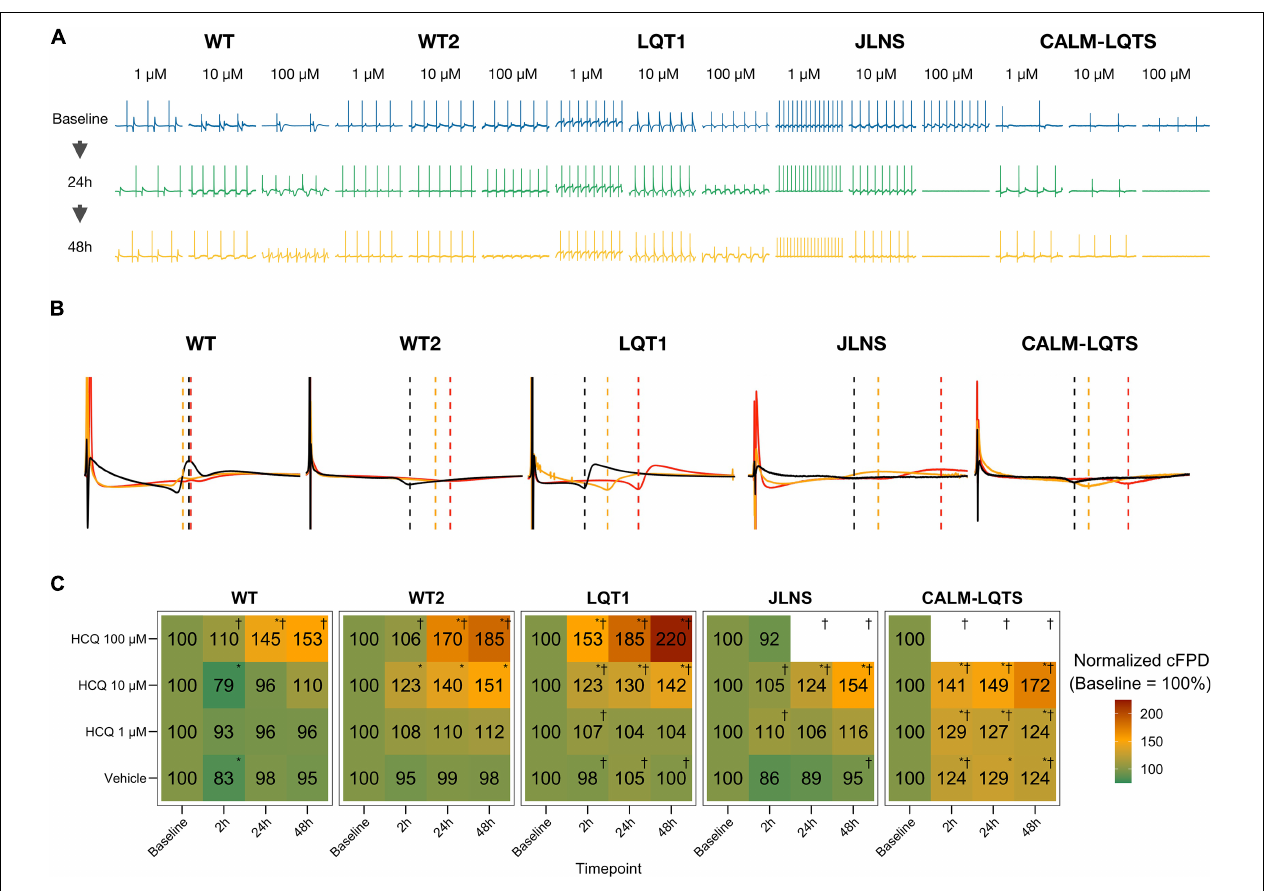
FIGURE 4 | (A) Representative examples of HCQ effect on MEA recordings. (B) Representative mean FP profiles of MEAs treated with 10 µ M HCQ at Baseline (black), after 24 h (yellow) and 48 h (red) exposure. (C) Mean FPD change, expressed as% and normalized to the respective Baseline value. Color code indicates the relative cFPD change compared to Baseline. * Indicates p < 0.05 vs. Baseline. † Indicates that the treatment caused the cessation of beating at a specific combination of Dosage and